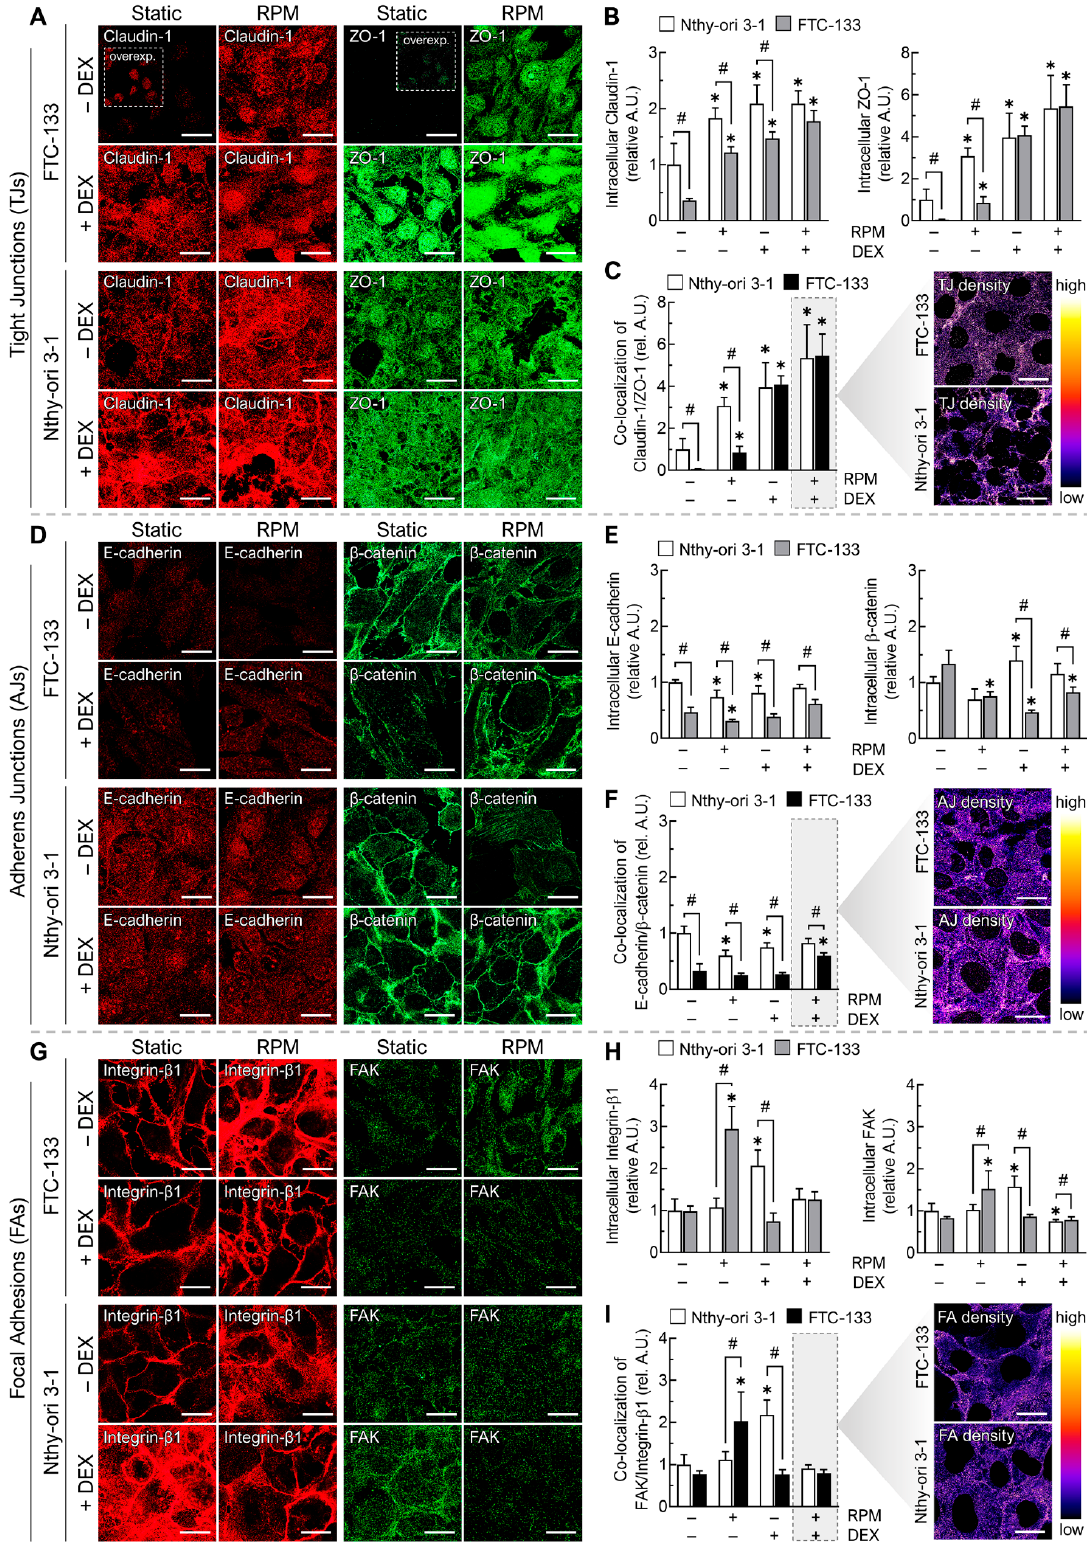
Figure 5. Effect of DEX (1000 nM) and random positioning on the cell junctions of FTC-133 and Nthy-ori 3-1 cells after 3 days. ( A ) Immunofluorescence of claudin-1 (red) and ZO-1 (green). The small inserts show low signal pictures with higher brightness; ( B ) fluorescence-based